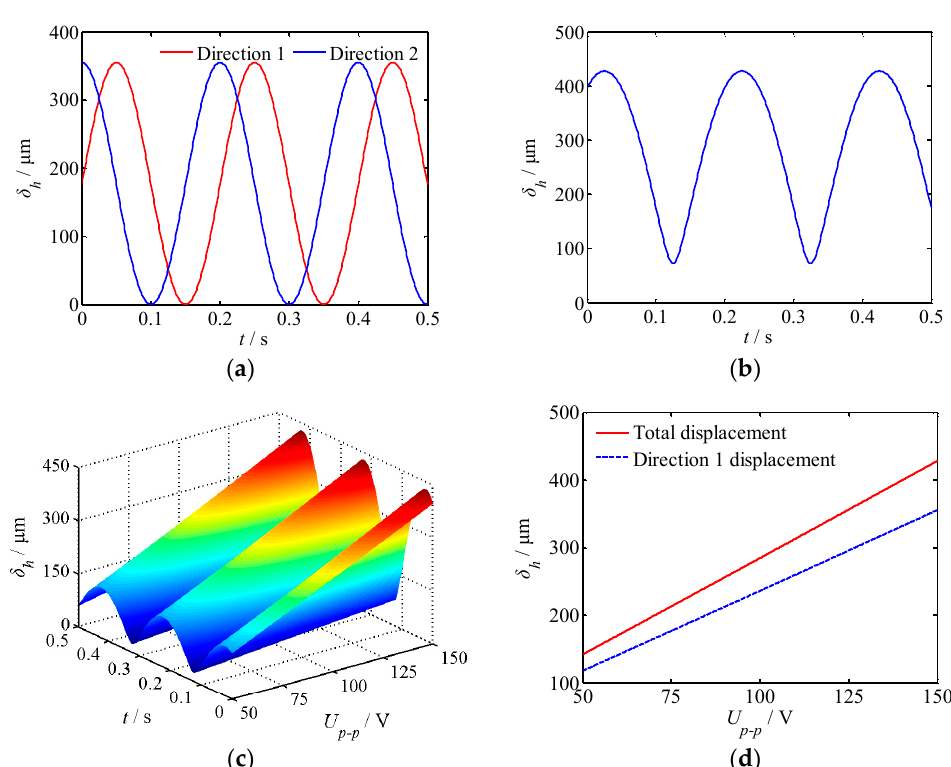
Figure 9. Calculation results of harmonic displacement. ( a ) Output harmonic displacement in both directions; ( b ) Total harmonic displacement; ( c ) Harmonic displacements that vary with time and voltage; ( d ) Comparison of total displacement and unidirectional displacement.